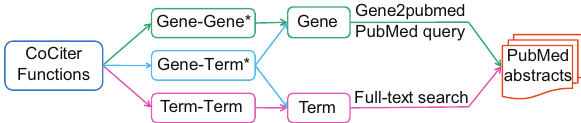
Figure 1. Schematic view of the functions in CoCiter. The Gene- Gene and Gene-Term association analysis functions (asterisked) include